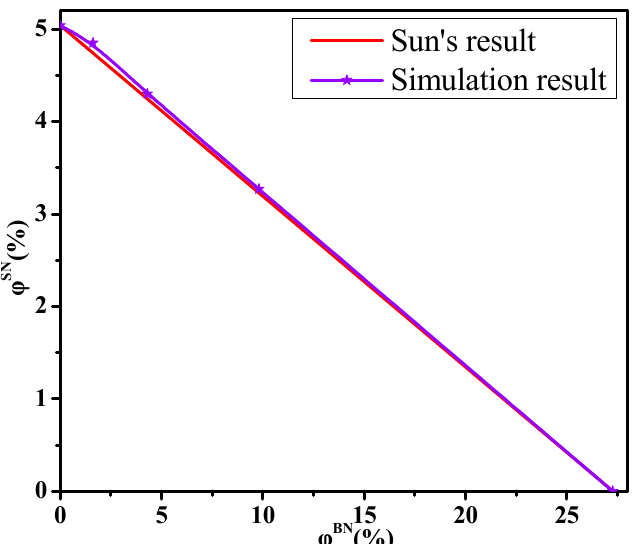
Figure 5. The dependence of the concentration of small nanoparticles (NPs) ( ϕ SN ) on that of big NPs ( ϕ BN ) at the percolation threshold.